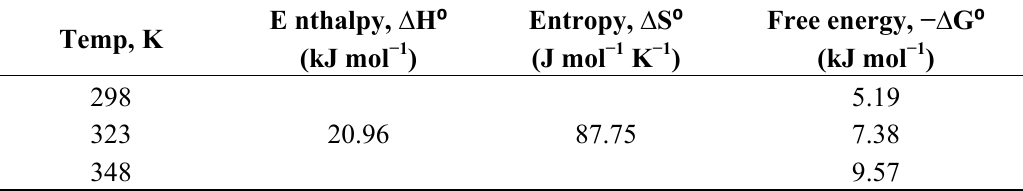
Table 3. Thermodynamic parameters for copper adsorption by peh-g-opefb. Temp,